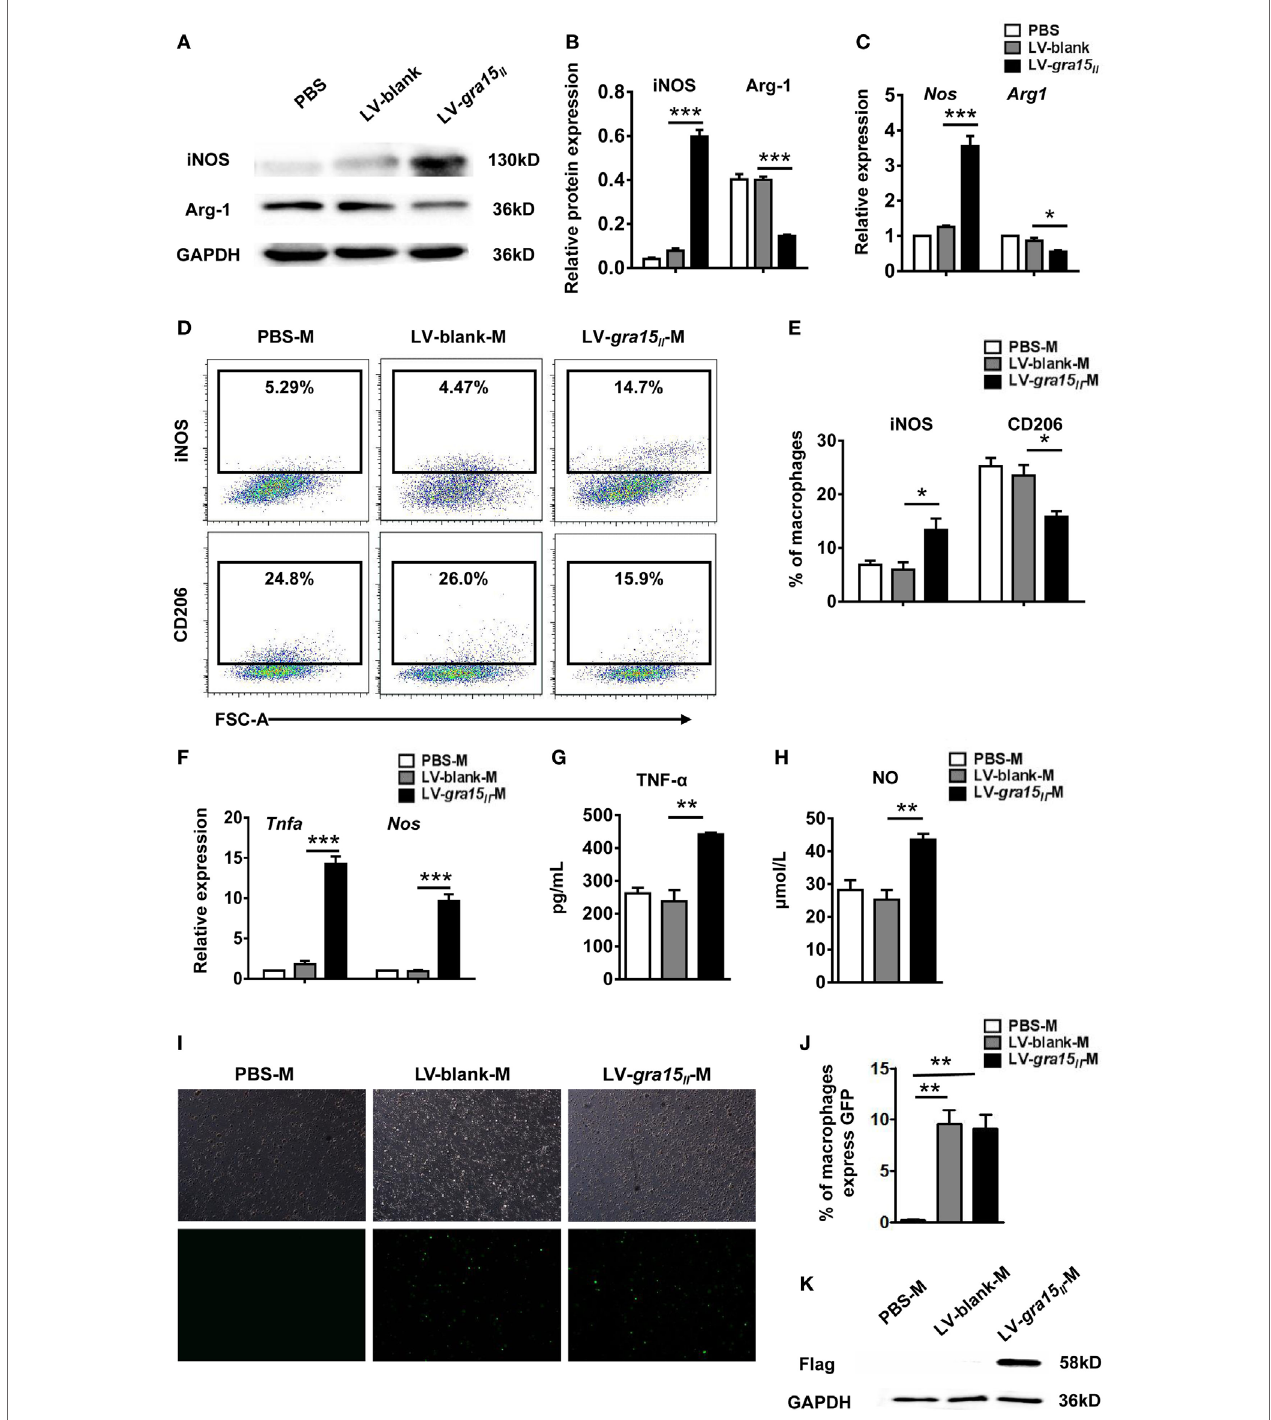
FigUre 2 | Lentiviral vector- gra15 II entered to liver and induced liver macrophage into M1-like phenotype in mice. Liver protein was extracted and the production of inducible nitric oxide synthase (iNOS) and Arg-1 were detected by Western blotting (a,B) . Liver RNA was extracted and the expression of iNOS and Arg-1 were analyzed by quantitative real-time PCR (qRT-PCR) (c) . Macrophages were isolated from liver by density gradient centrifugation, and then were purified according to surface marker of F4/80 and CD11b by flow cytometry. The liver macrophage polarization state was determined by the expression of inducible nitric oxide synthase and CD206 (D,e) . The liver macrophages were analyzed for the expression of tumor necrosis factor-alpha (TNF- α ) and iNOS by qRT-PCR (F) . Culture supernatants of the liver macrophages were collected and assayed for the secretion of TNF- α and nitric oxide by enzyme-linked immunosorbent assay and Griess Reagent System, respectively (g,h) . Green fluorescent protein in the liver macrophages were observed under fluorescence microscope (i,J) . The flag tag in the liver macrophages was detected by Western blotting (K) . Data represent mean ± SD from multi-group experiments. * p < 0.05, ** p < 0.01, and *** p < 0.001 ( n = 4 each